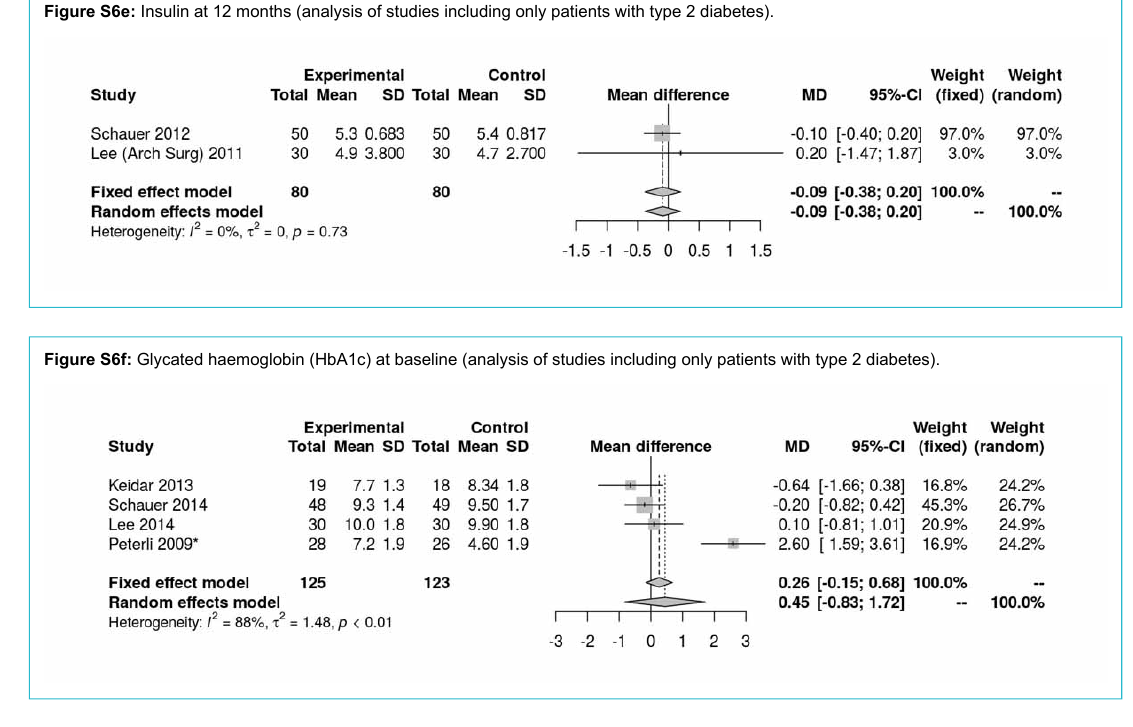
Figure S6g: HOMA index at baseline (analysis of studies including only patients with type 2 diabetes).